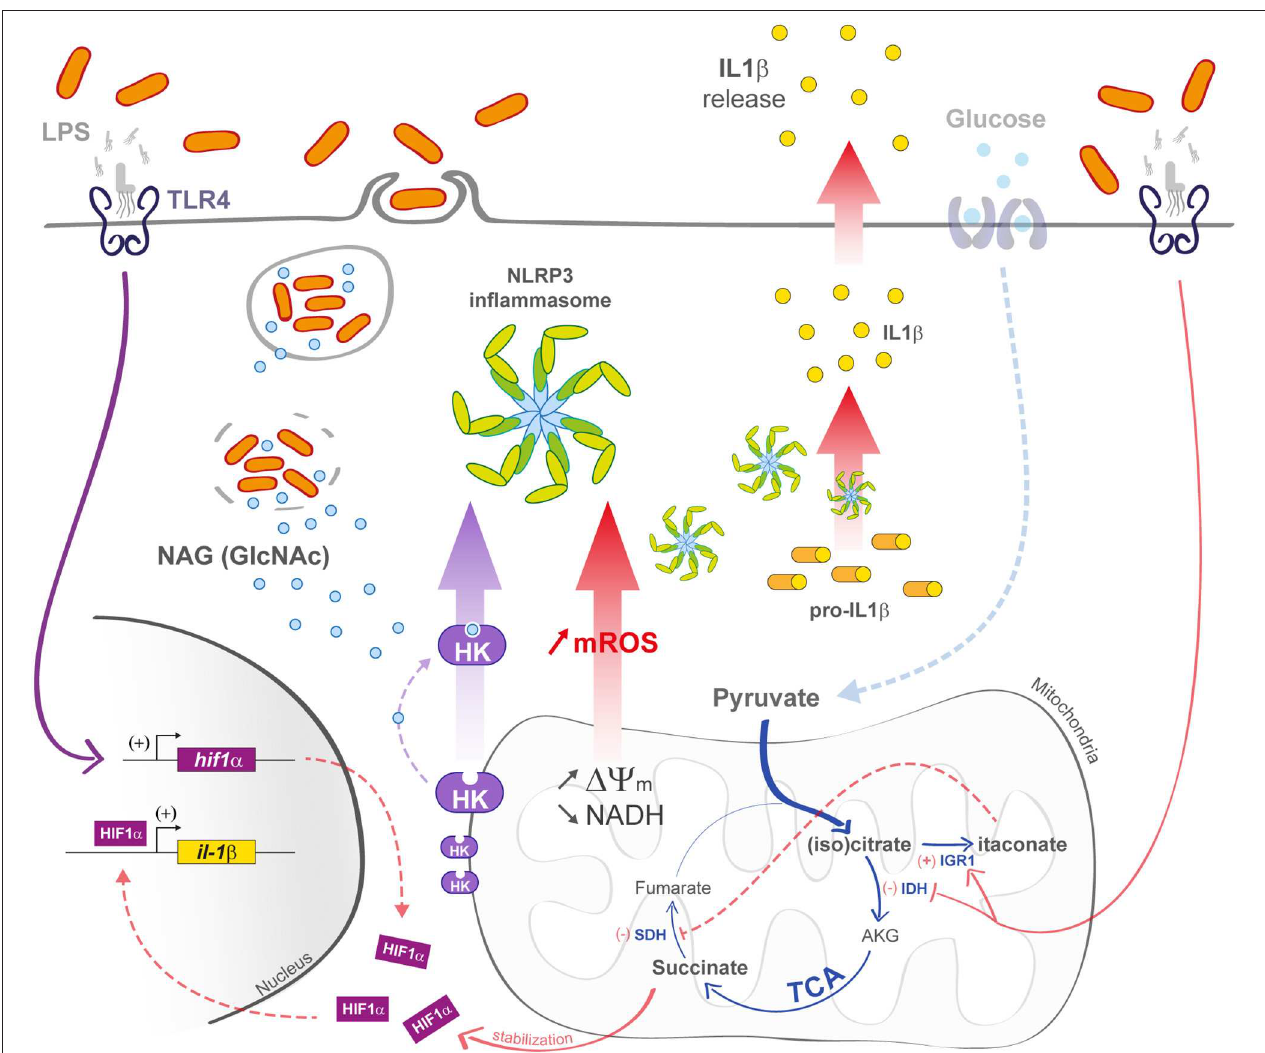
FIGURE 3 | M1 macrophage defenses upon bacterial infection. In M1 macrophages, the mitochondrial TCA cycle is shunted at the isocitrate dehydrogenase (IDH) step, subsequently leading to itaconate formation. The succinate dehydrogenase (SDH) step is also arrested, leading to succinate accumulation and IL-1 β transcription increase in a Hif1- α -dependent manner. Decrease in TCA cycle activity efficiency is also responsible for an increase in 19 m that induces the production of mROS. In bacteria-infected macrophages (left part), phagosomal maturation is responsible for N-acetylglucosamine (GlcNAc) release. GlcNAc binds mitochondrial hexokinase (HK) and induces its cytosolic release that activates NLRP3 inflammasome. mROS also induce NLRP3